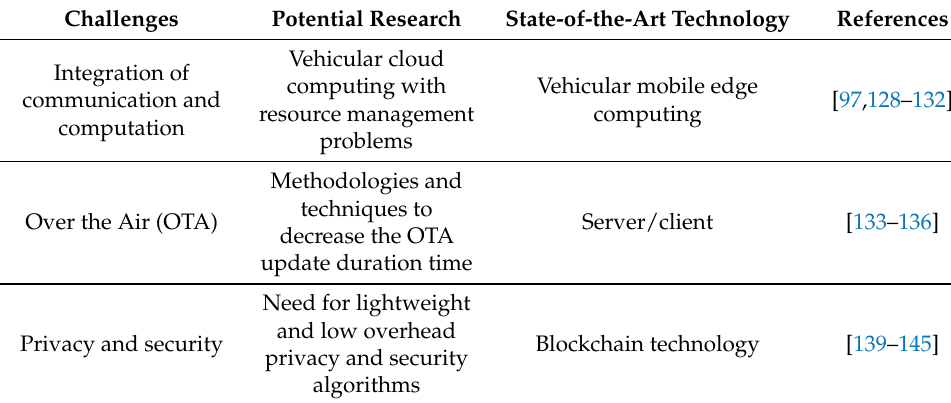
Table 3. Summary of the challenges in CV